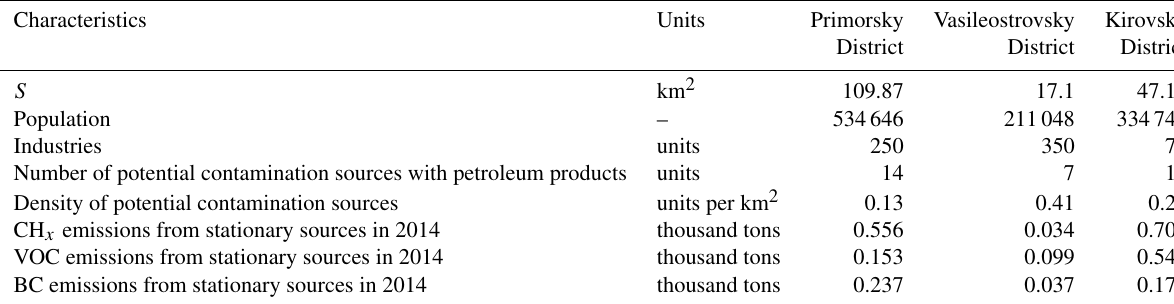
Table 1. Description of the study area.